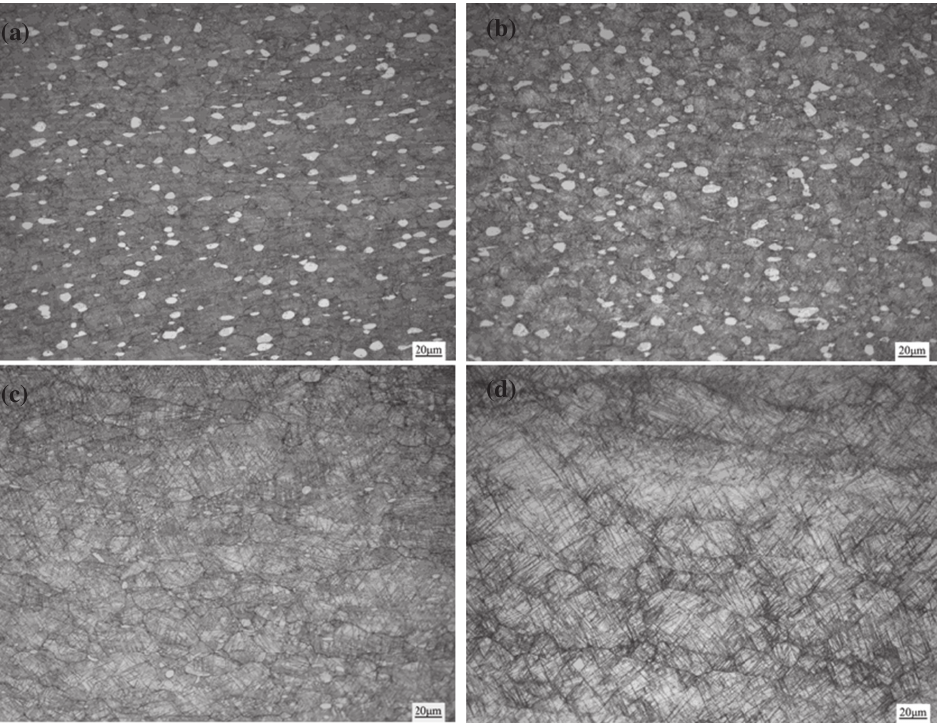
Figure 14: Microstructures under the strain rate of 0.1 s – 1 and deformation temperatures of: (a) 1,213 K; (b) 1,233 K; (c) 1,253 K; (d) 1,273